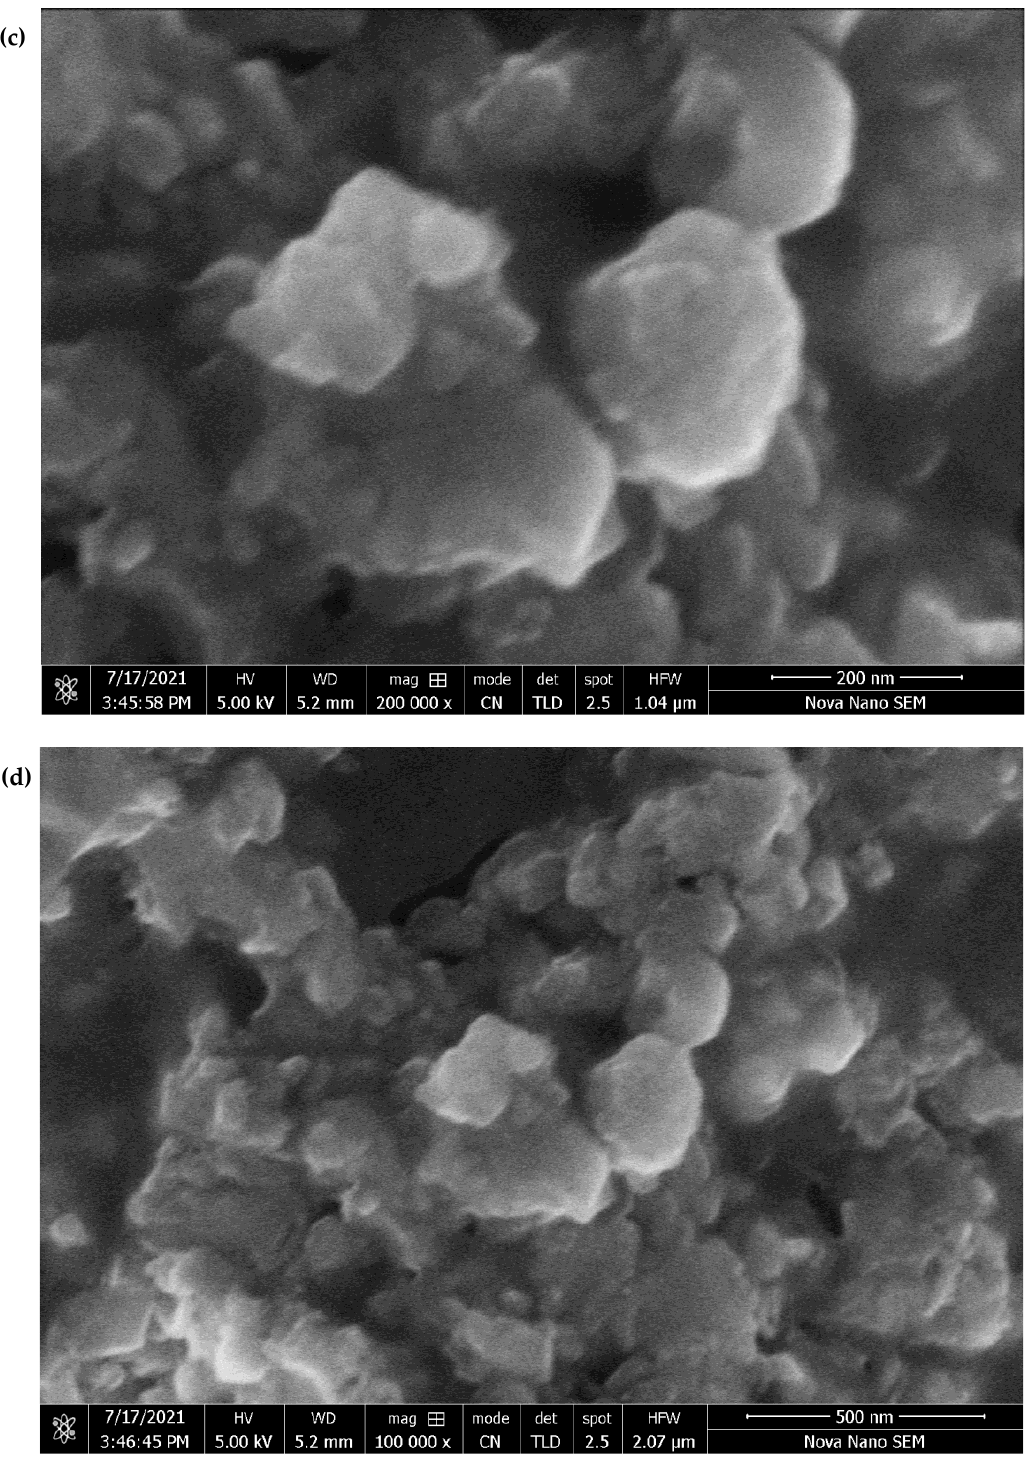
Figure 3. SEM images of ( a ) feldspar at 200 nm, ( b ) feldspar at 500 nm, ( c ) Li-TiO 2 /feldspar at 200 nm, ( d ) Li-TiO 2 /feldspar at 500 nm.